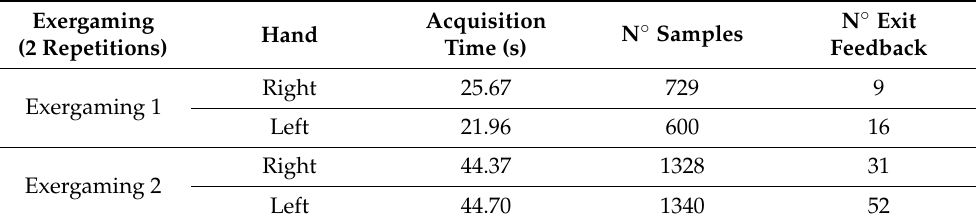
Table 1. Data acquired by the HL2 for the two exergaming exercises. The data refer to the two repetitions consecutively